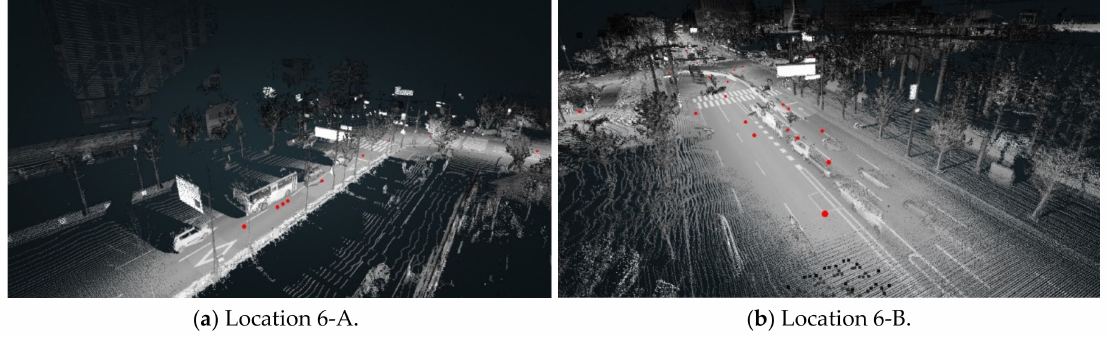
Figure 18. Unexpected VPD results due to moving